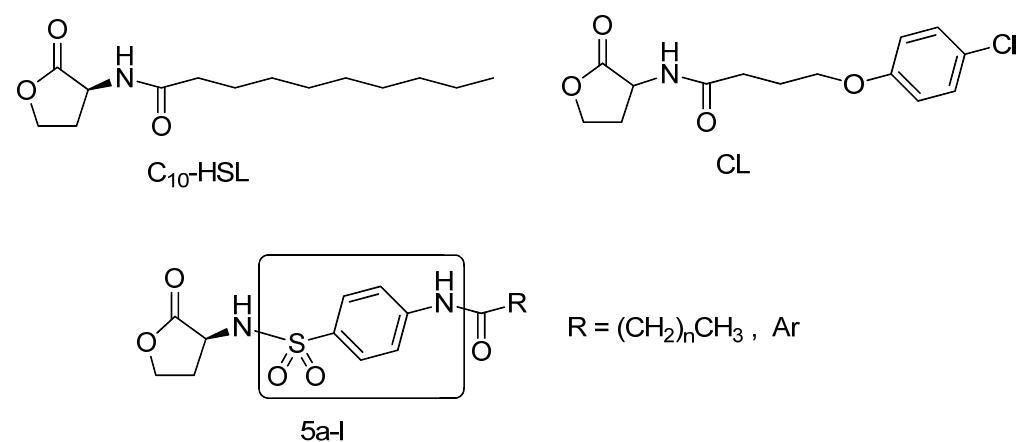
-HSL, CL and target compounds 5a – l 10